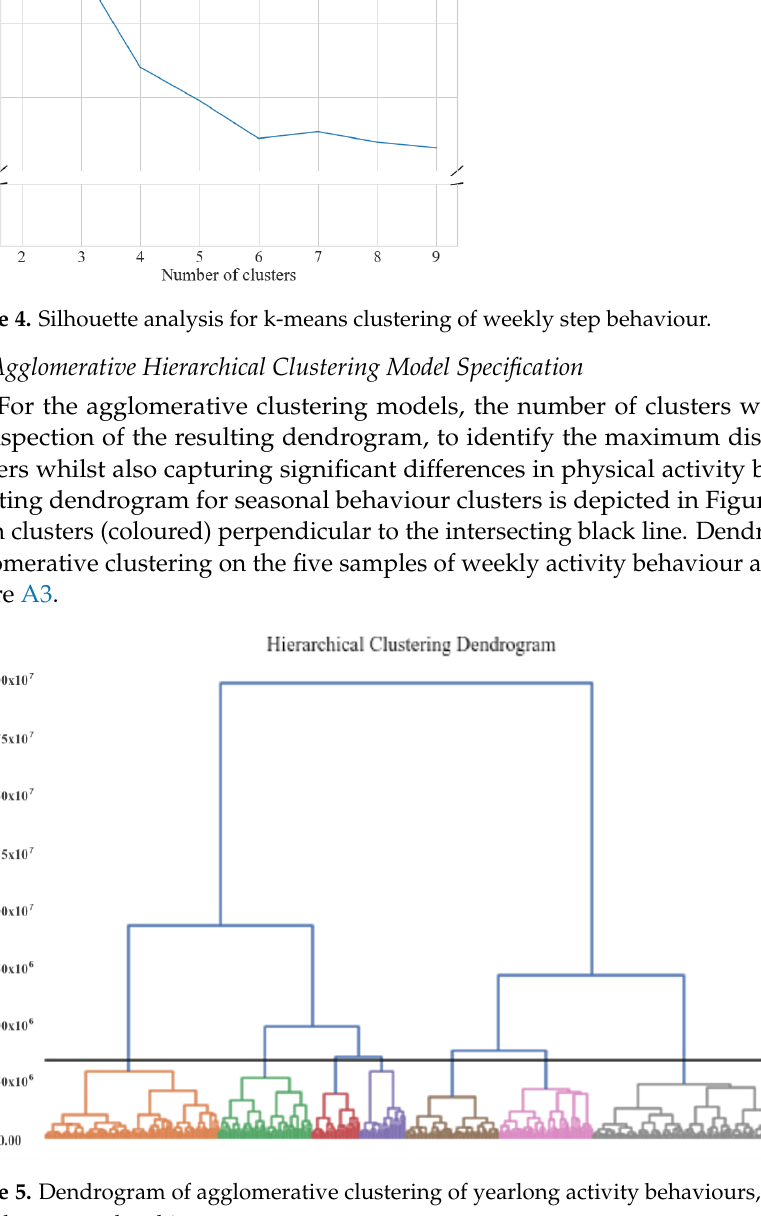
Figure 5. Dendrogram of agglomerative clustering of yearlong activity behaviours, colour indicates final cluster